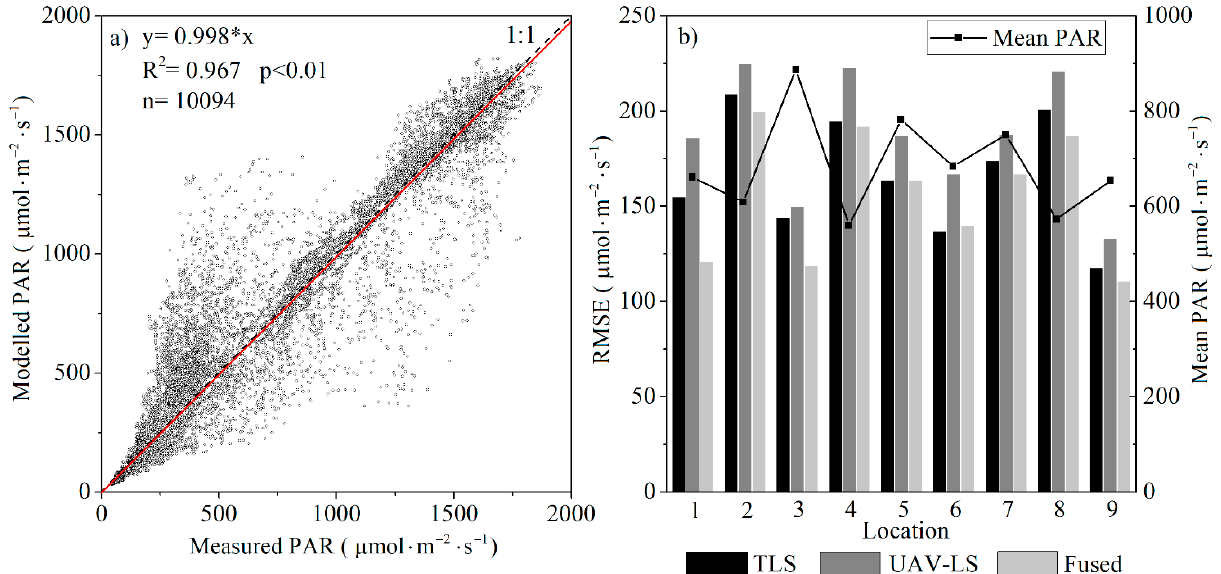
Figure 9. Observed vs. predicted sub-canopy PAR based on fused point cloud at all pyranometer locations (inset a ). Comparisons between PAR RMSEs using the LFSSL algorithm between the predicted and observed PAR based on TLS, UAV-LS, and fused point cloud (inset b ). The mean sub-canopy PAR is plotted on the secondary y -axis.